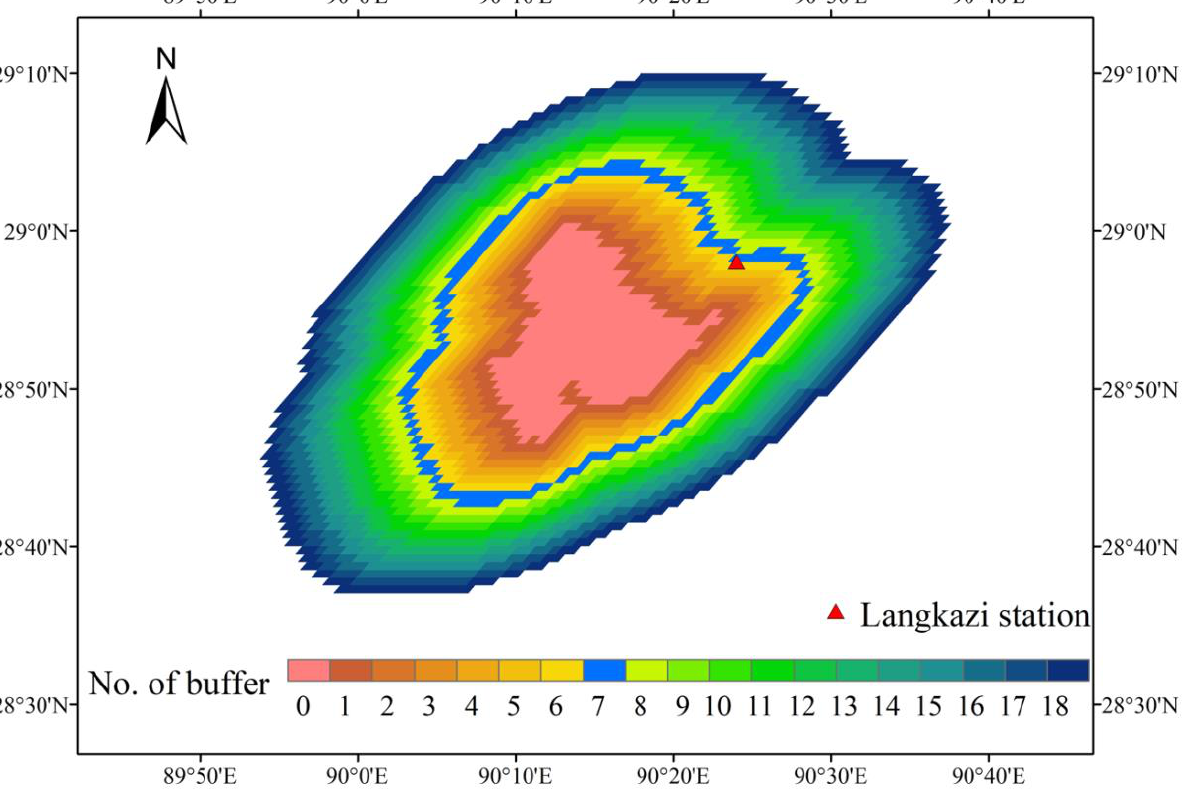
Figure 3. Distribution of the multiple ring buffers used in the new TLR scheme. The pink region is the extent of the Karuxung watershed (i.e., buffer No. 0); The sky-blue region is buffer No. 7 where the Langkazi meteorological station located.